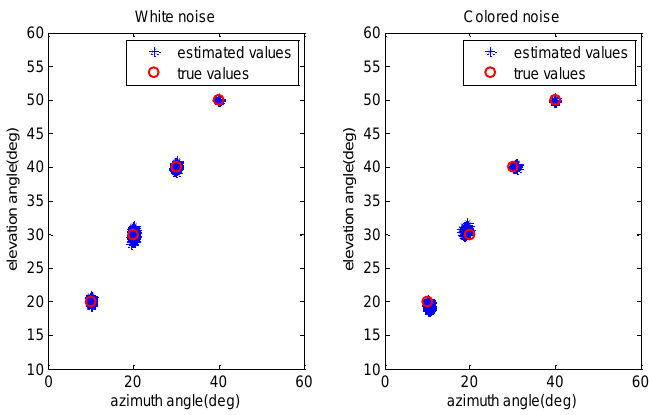
Figure 4. The estimated 2-D DOAs of FB-ISD method with 200 Monte Carlo trials.